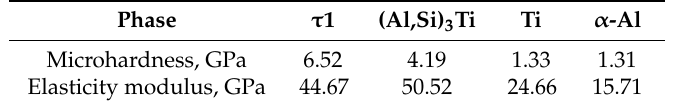
Figure 7. Plot of load vs depth of different phases in the reinforcing particles and Al matrix evaluated by a nanoindenter. Table 2. Results from nanoindentation test for different phases in the composites.